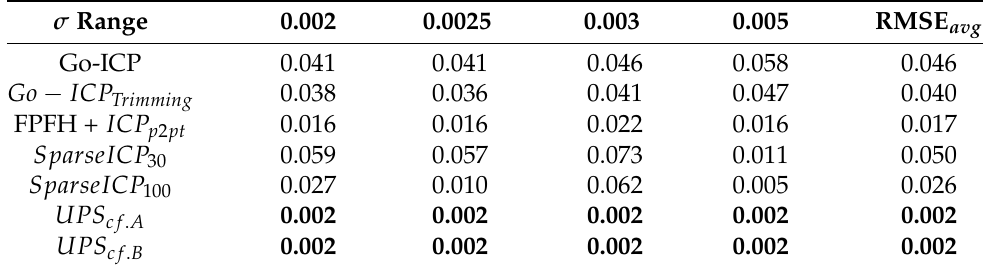
Table 8. RMSE (in meters) achieved by registration algorithms on Bunny model with noise level.